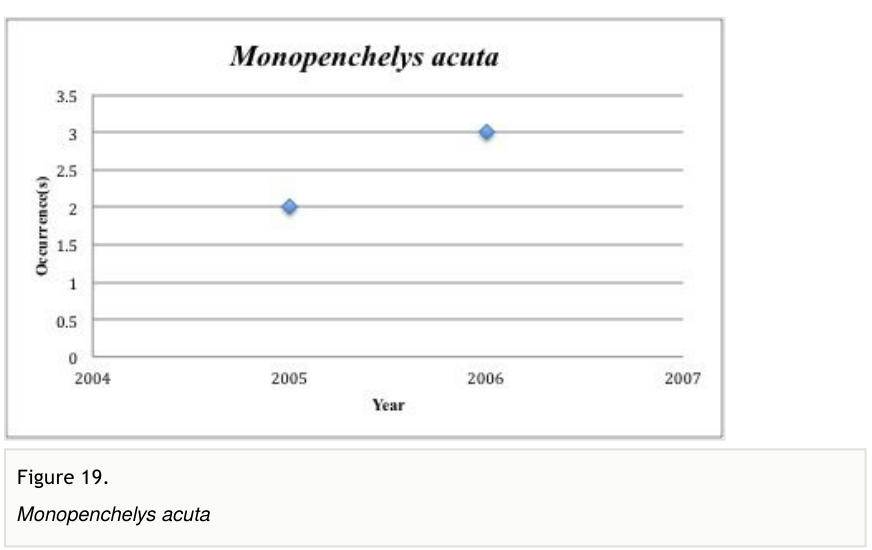
Figure 19. Monopenchelys